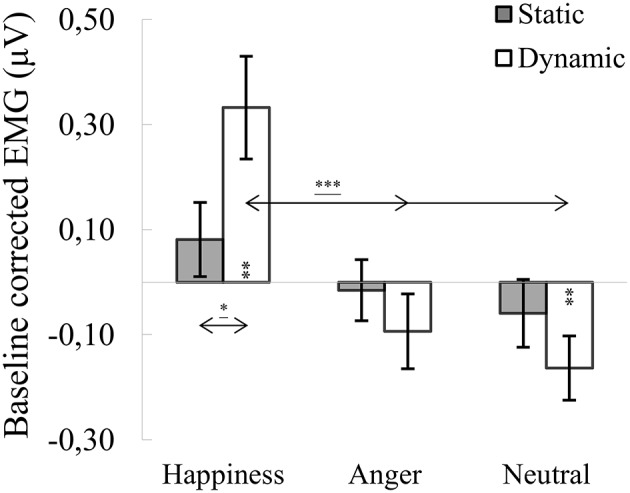
Mean (±SE) EMG activity changes and corresponding statistics for orbicularis oculi during presentation conditions. Asterisks with lines beneath indicate significant differences between conditions (simple effects) in EMG responses: *p < 0.05, ***p < 0.001. Separate asterisks indicate significant differences from baseline EMG responses: **p < 0.01.